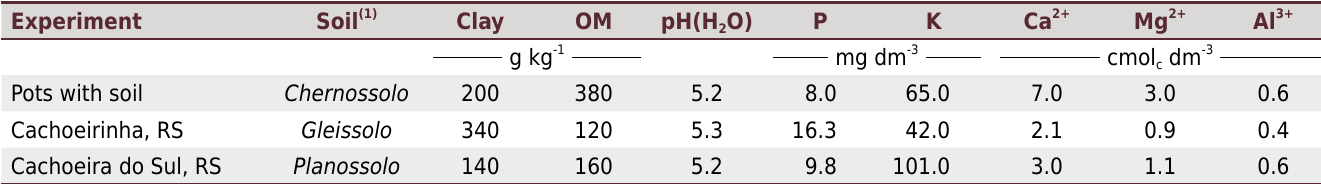
Table 1. Chemical properties of the soils used in the experiment Experiment Pots with